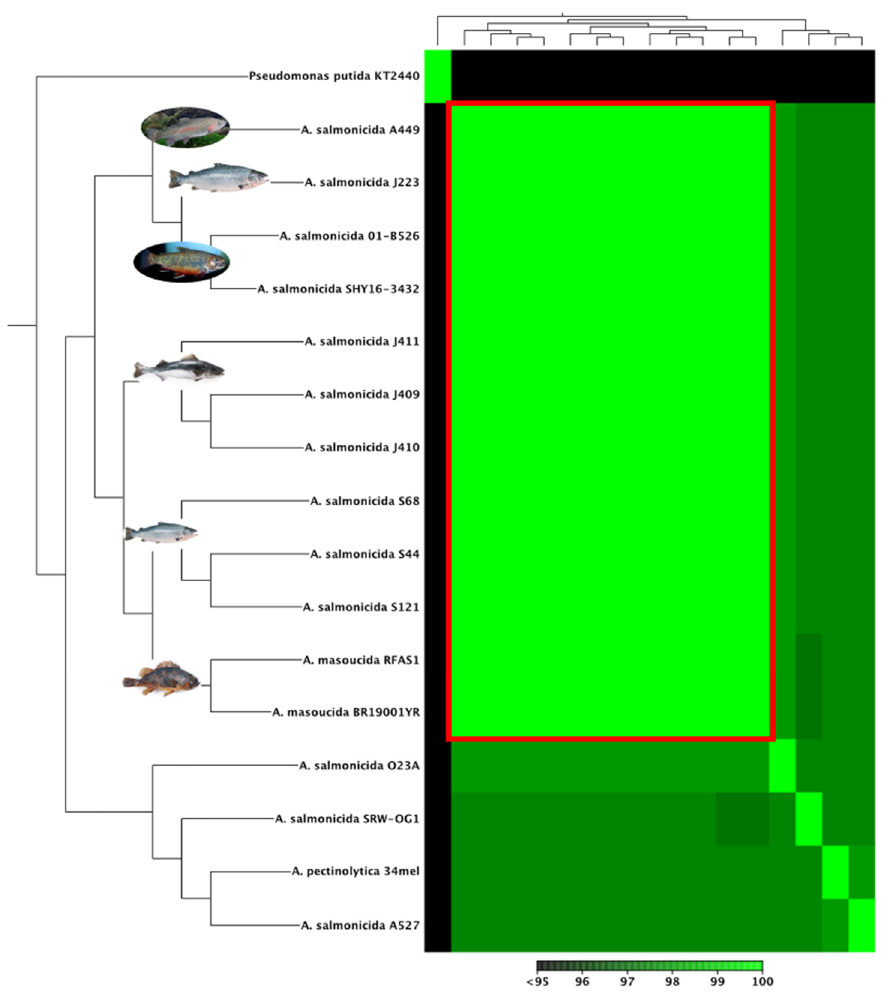
Figure 4. Comparative Aeromonas spp. whole-genome analysis. Heat map analysis visualization based on aligned Aeromonas spp. chromosomes. Images represent the origin of isolation. Color bar represents the percentage of identity within strains. Thirteen A. salmonicida subsp. salmonicida, two A. salmonicida subsp. masoucida RFAS1 and BR19001YR, and A. salmonicida subsp. pectinolytica 34mel were used for the analysis. Pseudomonas putida KT2440 was set up as an outgroup. Analysis was computed using CGWB.